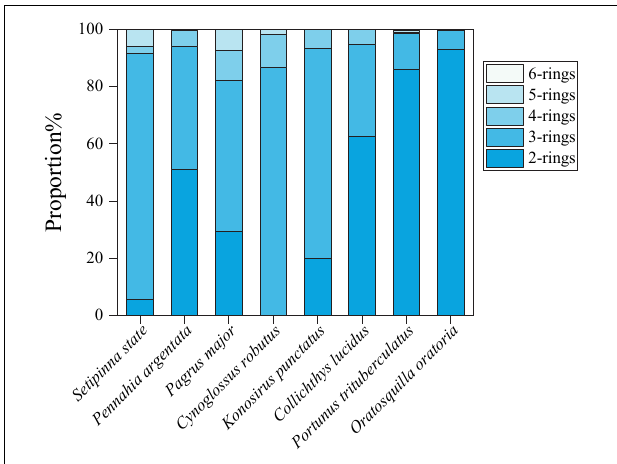
FIGURE 3 | Composition patterns of PAHs in the marine organisms.